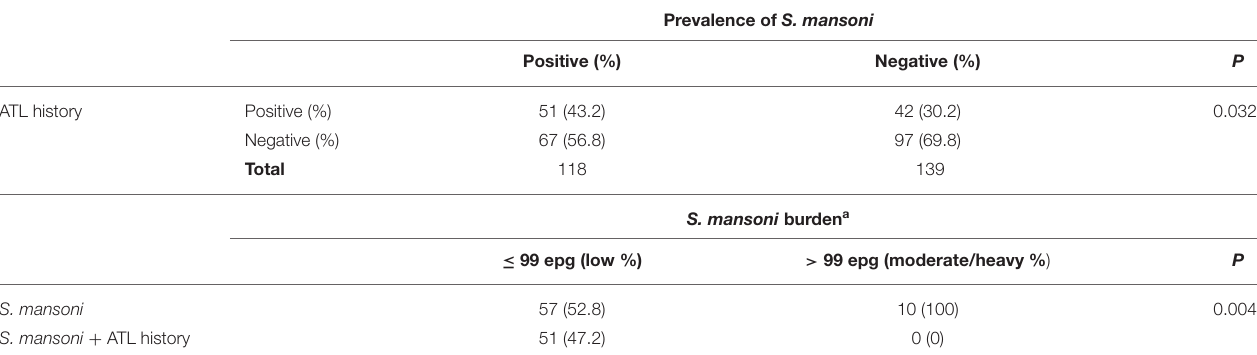
TABLE 2 | Parasite burden and prevalence of S. mansoni infection and report of ATL history in individuals living in the rural community of Brejo do Amparo, Januária, Minas Gerais, Brazil.